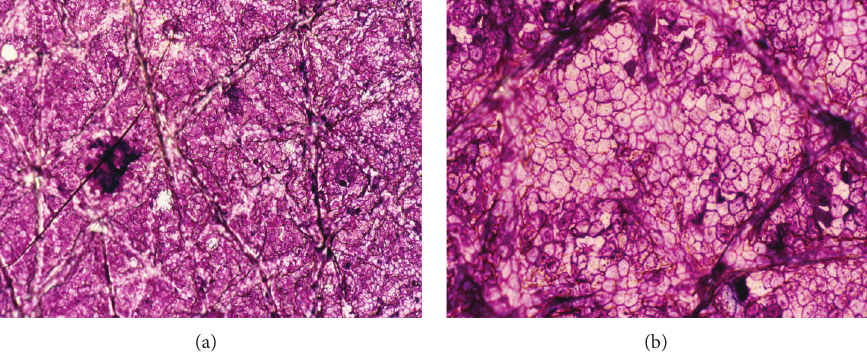
Figure 10: Corneosurfametry. (a) Dense positive staining throughout the CSSS. (b) Uneven surfactant reactivity of corneocytes.